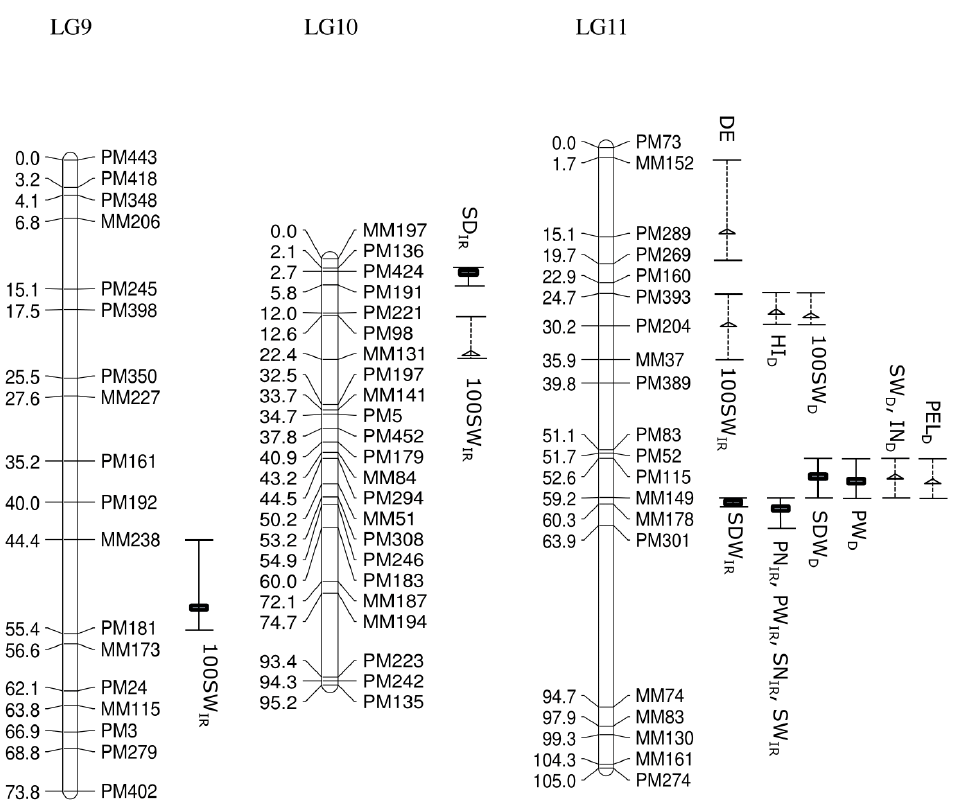
Figure 3. Map positions of the quantitative trait loci (QTL) in the irrigated (control) and drought treatment F 5 segregating population developed from a cross between Tiga Nicuru and DipC. GEMs’ identity is described on the right and map positions (cM) on the left. The rectangular box ( ) with the solid confidence intervals indicates the location of significant QTL and their flanking markers, whereas the triangular box (Δ) with dotted confidence intervals represents putative QTL and their neighbouring markers. DE, days to emergence; DF, days to flowering; EDP, estimated days to podding; IN, internode length; PEL, peduncle length; PN, pod number per plant; PW, pod weight per plant; SN, seed number per plant; SW, seed weight per plant; 100SW, 100-seed weight; SDW: shoot dry weight; HI, harvest index; SC, stomatal conductance; CID, leaf carbon (Delta C 13 ) isotope analysis; SD, stomatal density; NID, leaf (Delta N 15 ) isotope analysis .